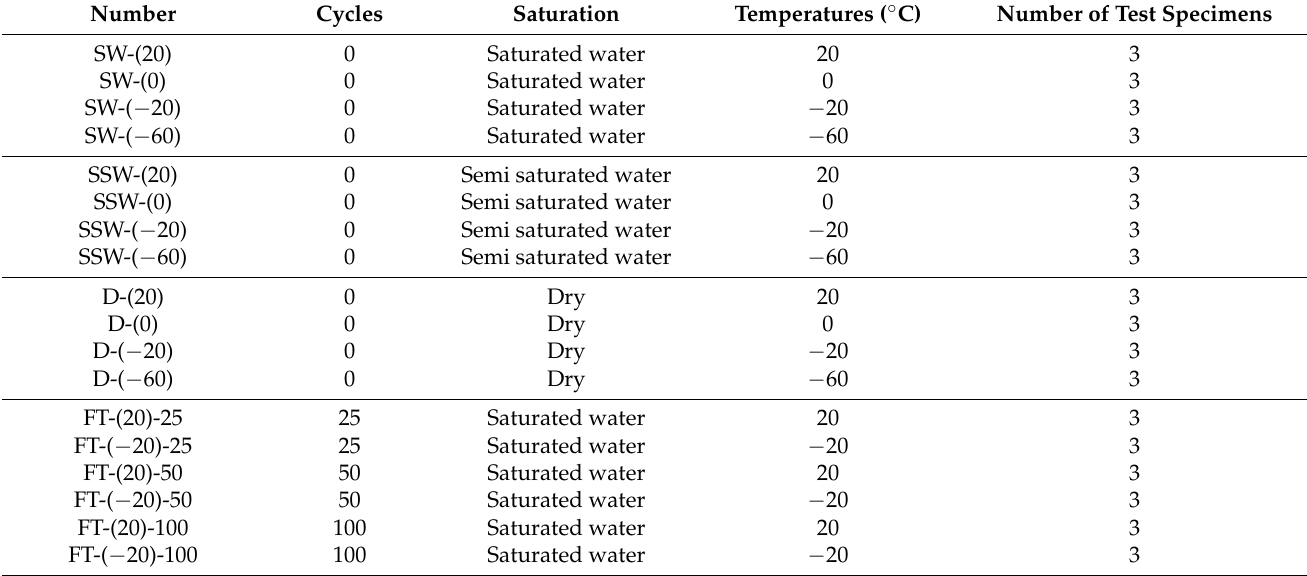
Table 4. Serial number of